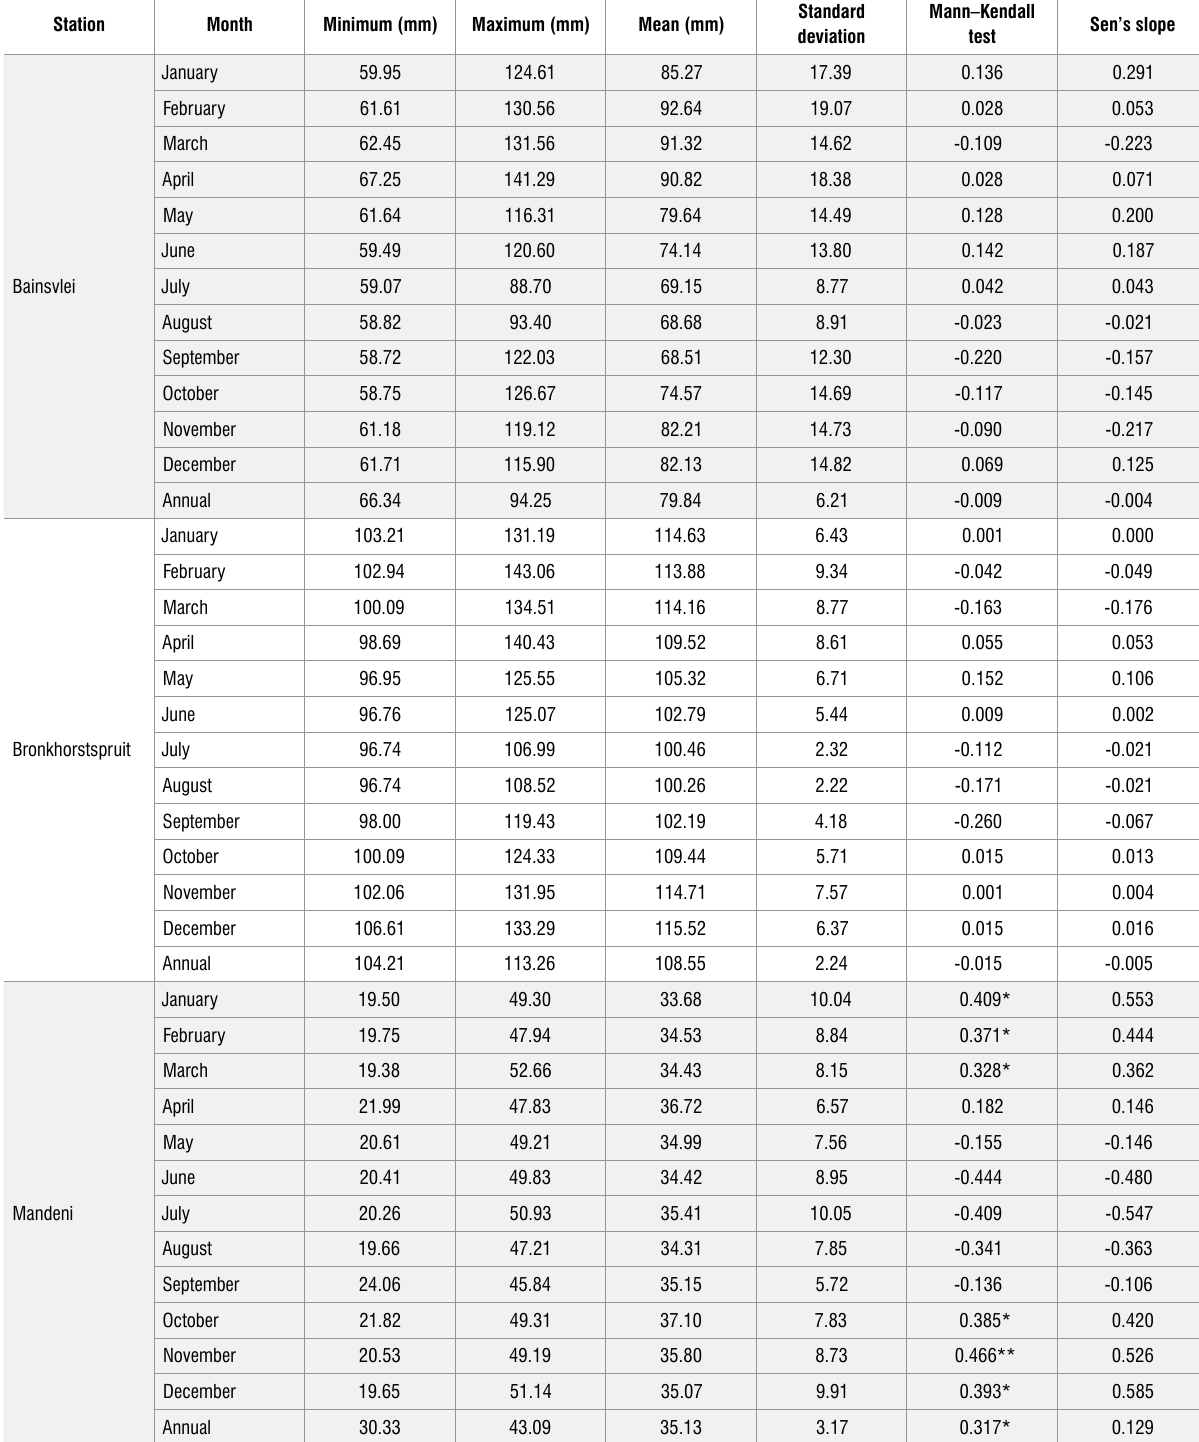
Basic statistics and Mann–Kendall trend analysis of soil moisture for 39 years (1980–2018) at all stations